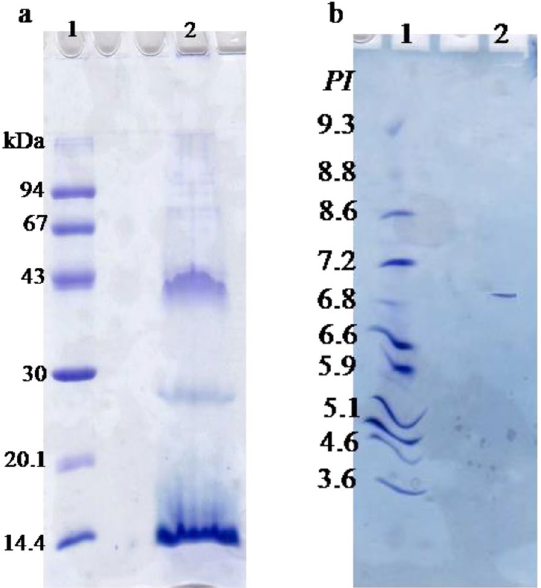
Fig. 2 a Analysis of TLGST on 12% SDS PAGE; (1) molecular weight marker proteins, (2) TLGST. b Analysis of TLGST on isoelectric focusing PAGE: (1) pI marker proteins, (2) TLGST